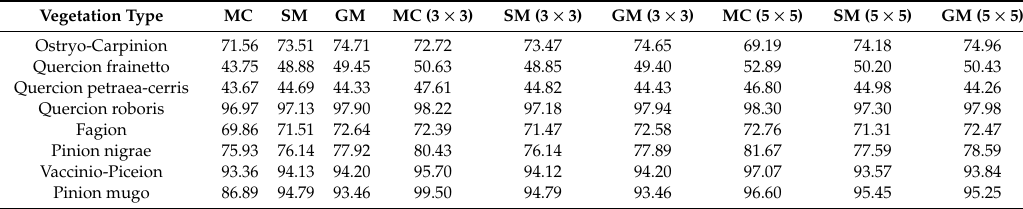
Table A5. User’s accuracy for all woody vegetation classes for 10-fold LLOCV.